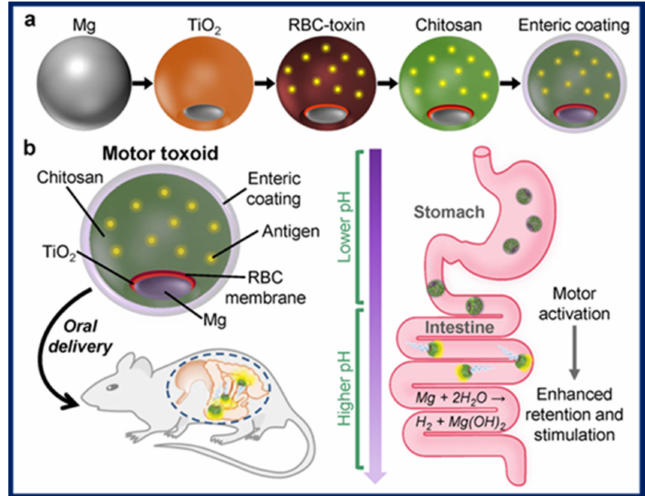
Figure 5. ( a ) Microswimmer fabrication steps: magnesium microparticles are first partially coated with titania, then with a red blood cell (RBC) membrane containing the toxin, chitosan for mucoadhesion, and finally with an enteric coating resistant to acidic pH. ( b ) Principle of action for oral vaccination in mice using the microswimmers (motor toxoids) as delivery agents. Figure reproduced from [87], © 2019 American Chemical